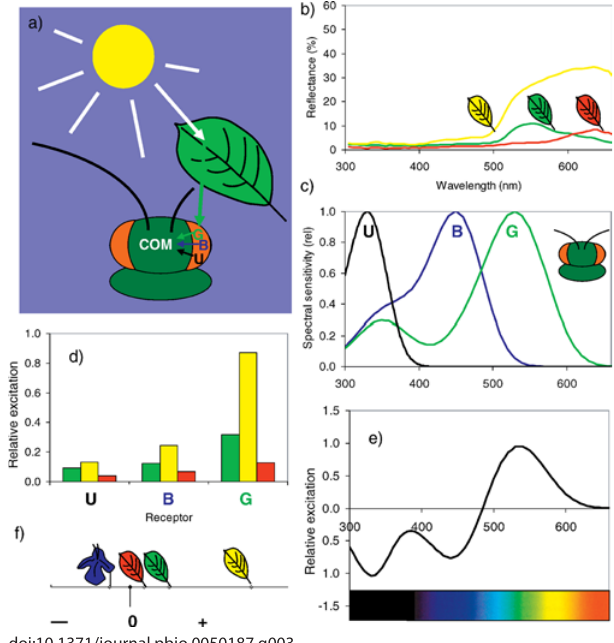
Figure 3. The Perception of Colored Leaves by an Aphid (A) A green leaf refl ects the light from the sun and is seen by an aphid with a green (G), blue (B), and ultraviolet (U) photoreceptor [29]. Evidence from behavioral studies [31] indicates that a COM processes the input from the photoreceptors. (B) Refl ectance spectra of three leaves from the bird-cherry, Prunus padus. To humans, these leaves appear green, red, and yellow. For measurement methods see [26]. (C) Tentative spectral sensitivities of the green peach aphid’s UV, blue, and green photoreceptors. (D) Relative excitation of the UV, blue, and green photoreceptors produced by the green, yellow, and red bird- cherry leaves shown in (B). For methods of calculation, see [48]. (E) Excitation spectrum of a COM inferred from behavioral data [26,31]. The mechanism is fed by the three photoreceptors in (C), with positive input from the green and negative input from the other two receptors. Based on behavioral data, a mechanism of this kind is presumably what many insect herbivores use as a “greenness detector.” (F) Excitation of the COM by the three bird-cherry leaves and a blue-purple fl ower (Ajuga genevensis) on a one-dimensional scale. Note how the yellow leaf produces an even more positive signal than the green